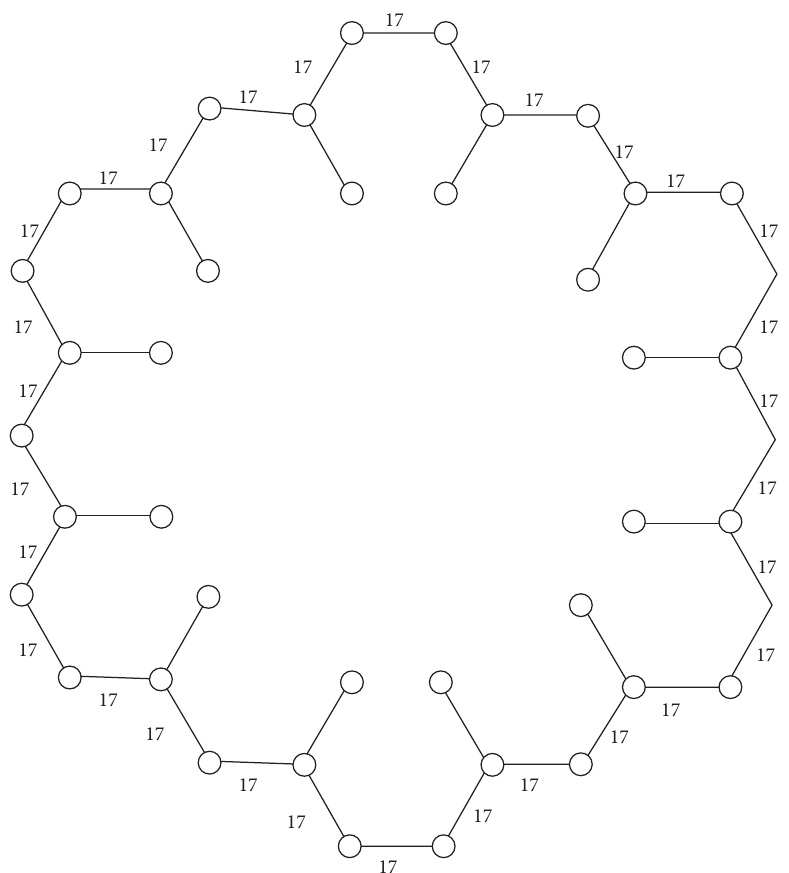
Figure 9: The labels of all edges of the outer cycle C